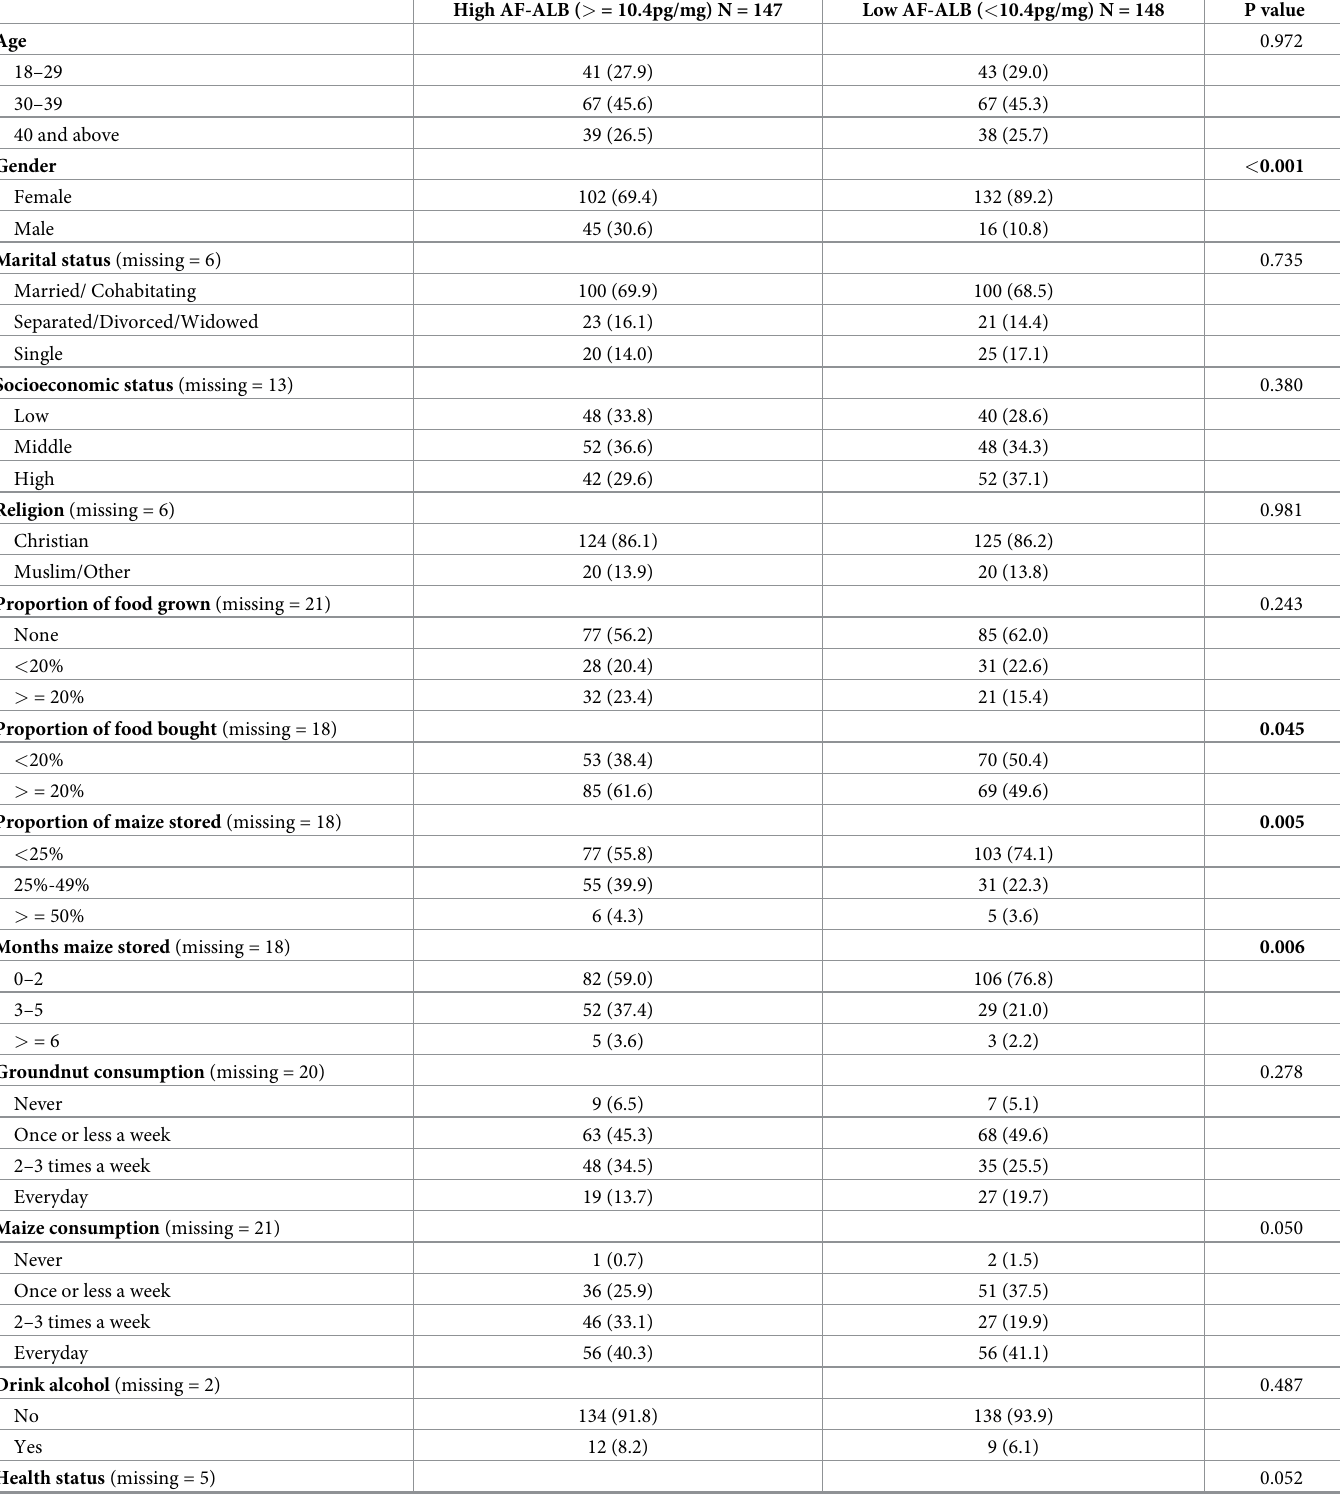
Table 1. Descriptive statistics of the study participants by median baseline aflatoxin albumin adduct (AF-ALB)